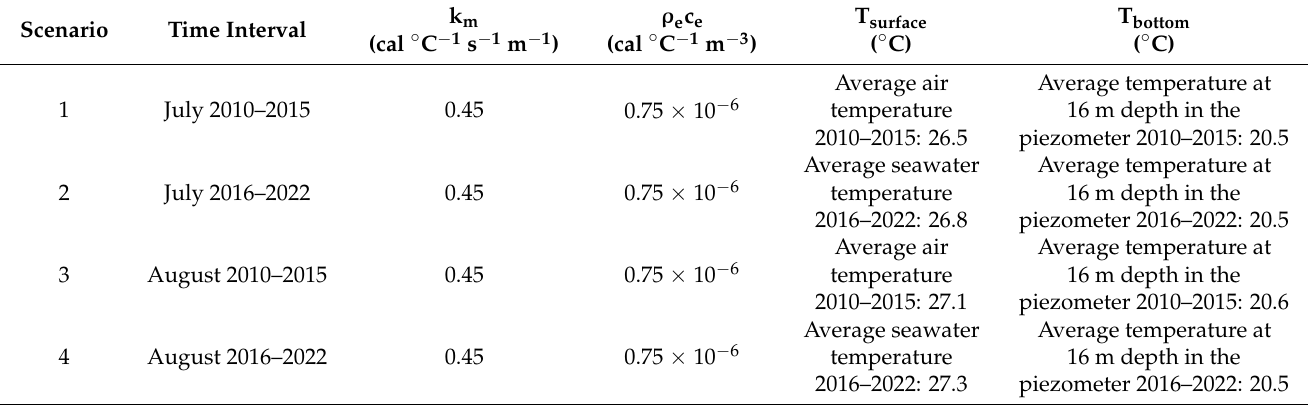
Table 1. Boundary conditions and parameters defined in scenarios 1–4 of